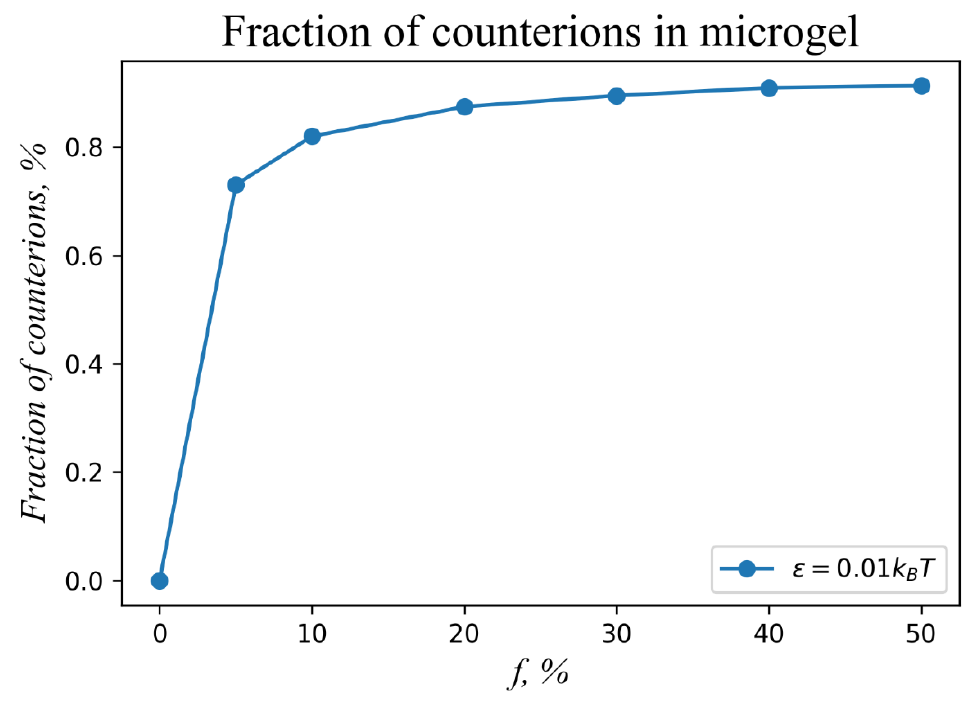
Figure 5. Fraction of counterions localized within the charged microgel as a function of the fraction of charged groups of the network f . The molecular weight and subchain length of the microgel are N = 100,000 and M = 10, respectively. The initial aspect ratio is A = 10. The microgel is modeled under favorable solvent conditions, ε = 0.01 kT .